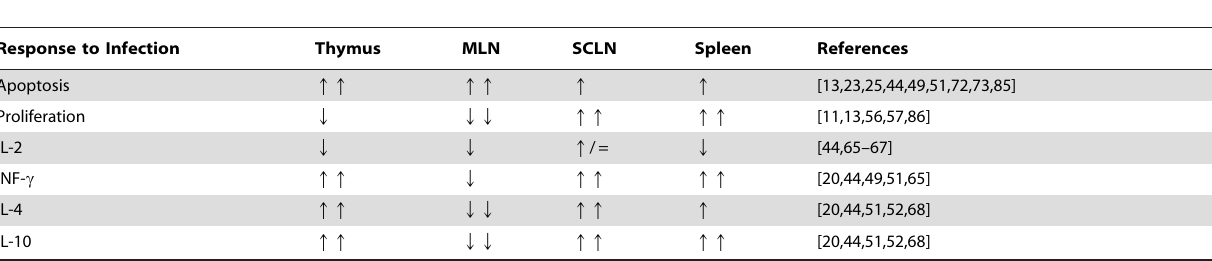
Differences between normal versus infected mice are indicated with the arrows.